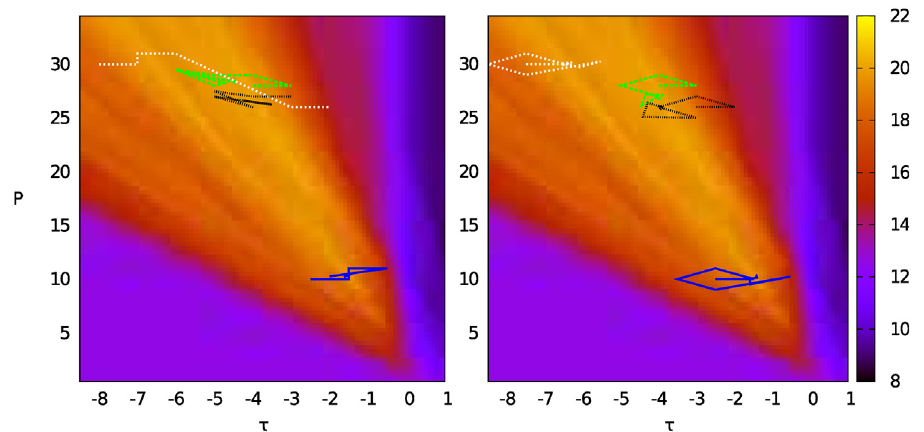
Fig 8. Optimization trajectories for Nelder-Mead (left) and BOBYQA (right) with four different start values.